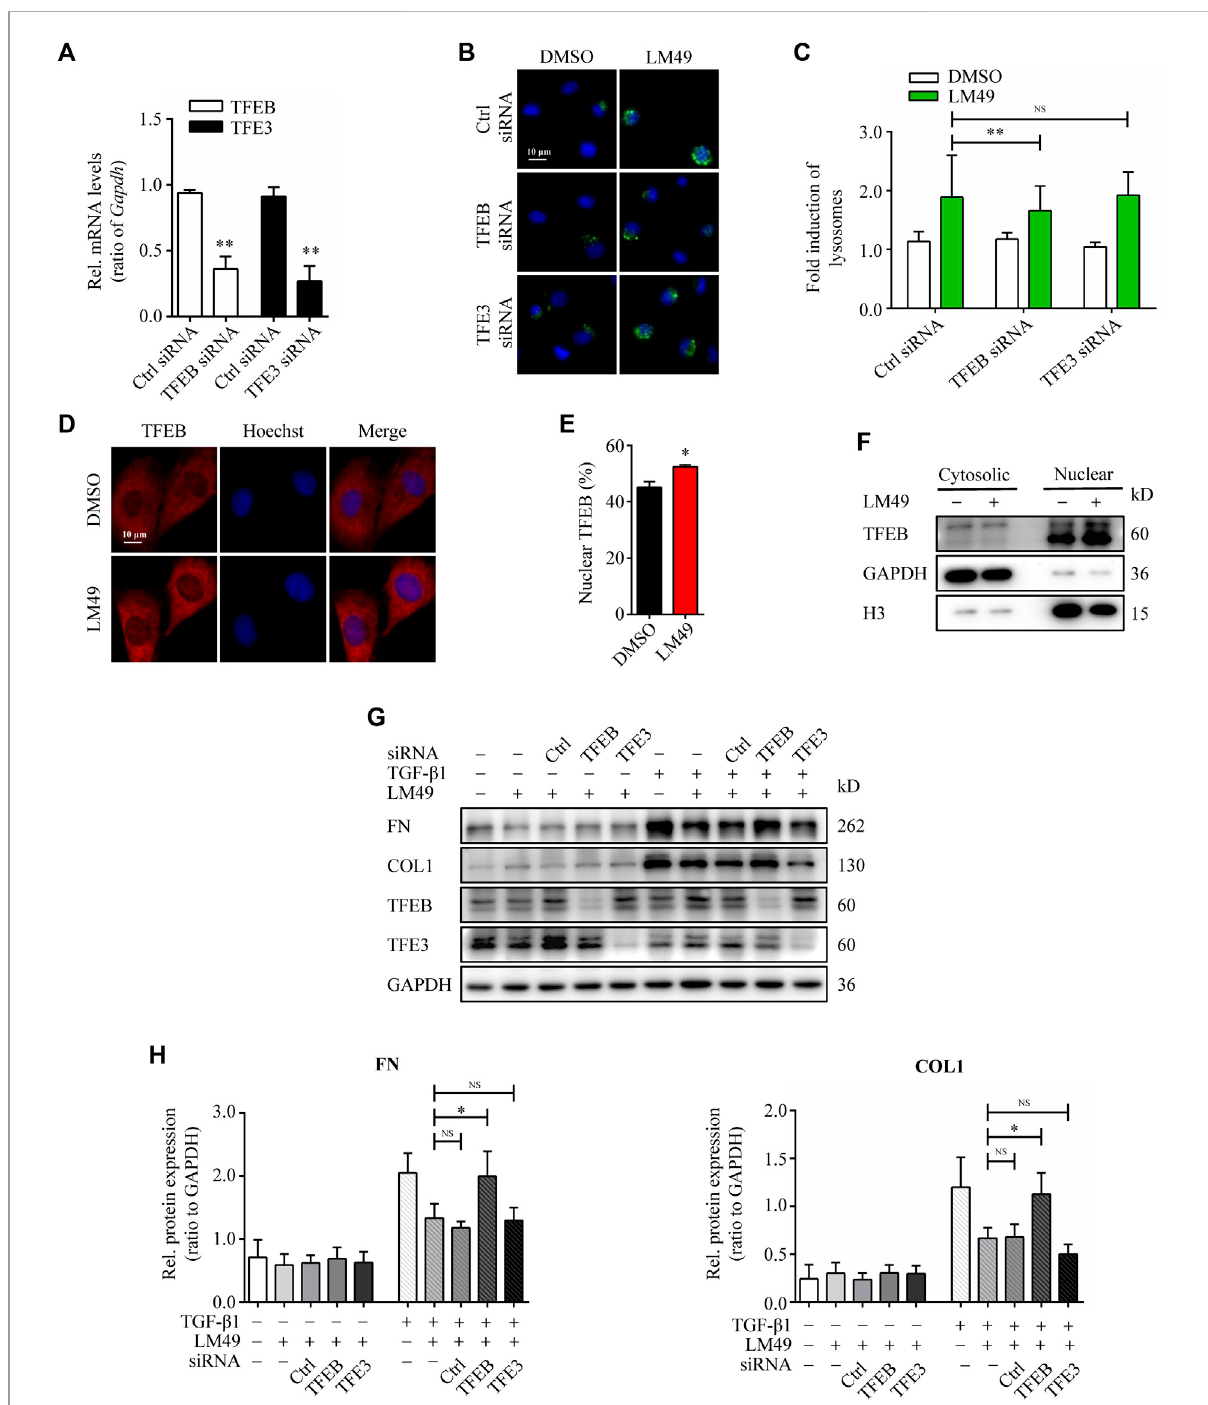
FIGURE 4 TFEB-dependent lysosome biogenesis is required for LM49-induced ECM protein degradation. (A) Quantitative RT-PCR analysis of the mRNA levels of TFEB and TFE3 inNRK49F cells treated with control (Ctrl) siRNA, TFEB siRNAor TFE3 siRNA.** p < 0.01 comparedwith Ctrl siRNAgroup (n = 3). (B) LysoTracker Green staining in DMSO-treated or LM49 (20 μ M)-treated NRK49F cells transfected with Ctrl siRNA, TFEB siRNA or TFE3 siRNA. (Scale bar, 10 μ m). (C) Quanti fi cation of LysoTracker Green intensity of (B) . ** p < 0.01 compared with Ctrl siRNA + LM49 group (n = 3) (D) Immunostaining of TFEB analysing the subcellular localization in NRK49F cells treated with DMSO or LM49 (20 μ M) for 24 h (Scale bar, 10 μ m). (E) Quanti fi cation of the ratio of nuclear TFEB to total TFEB in (D) . * p < 0.05 compared with DMSO group (n = 3). (F) Immunoblot analysis of the protein expression of cytosolic and nuclear TFEB in NRK49F cells treated with DMSO or LM49 (20 μ M) for 24 h. (G) Immunoblot analysis of the protein expression of FN and COL1 in DMSO-treated or LM49 (20 μ M)-treated NRK49F cells transfected with Ctrl siRNA, TFEB siRNA or TFE3 siRNA in